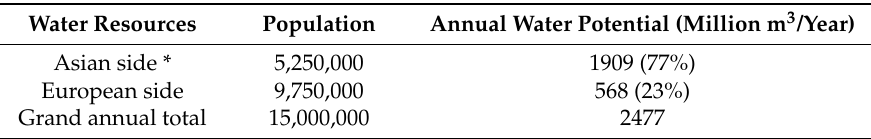
Table 1. Water resources and the population distribution for